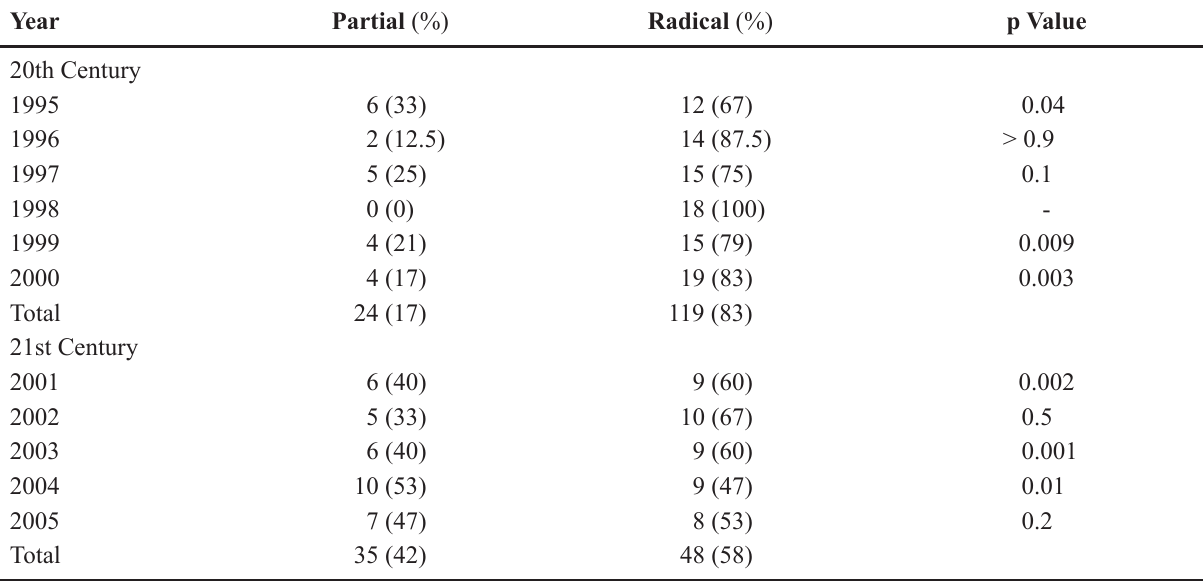
Table 3 – Percentage distribution of surgeries performed during the period of 1995 - 2000 and 2001 -